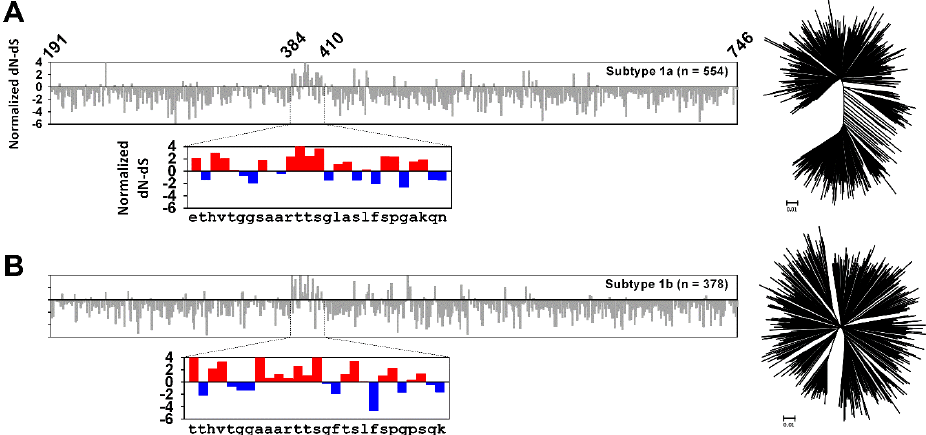
Figure 3. Characterization of positive and negative selection in HCV subtype 1a and 1b envelope glycoproteins . For each panel, full-length E1E2 nucleotide sequences were downloaded from GenBank and aligned according to encoded amino acid